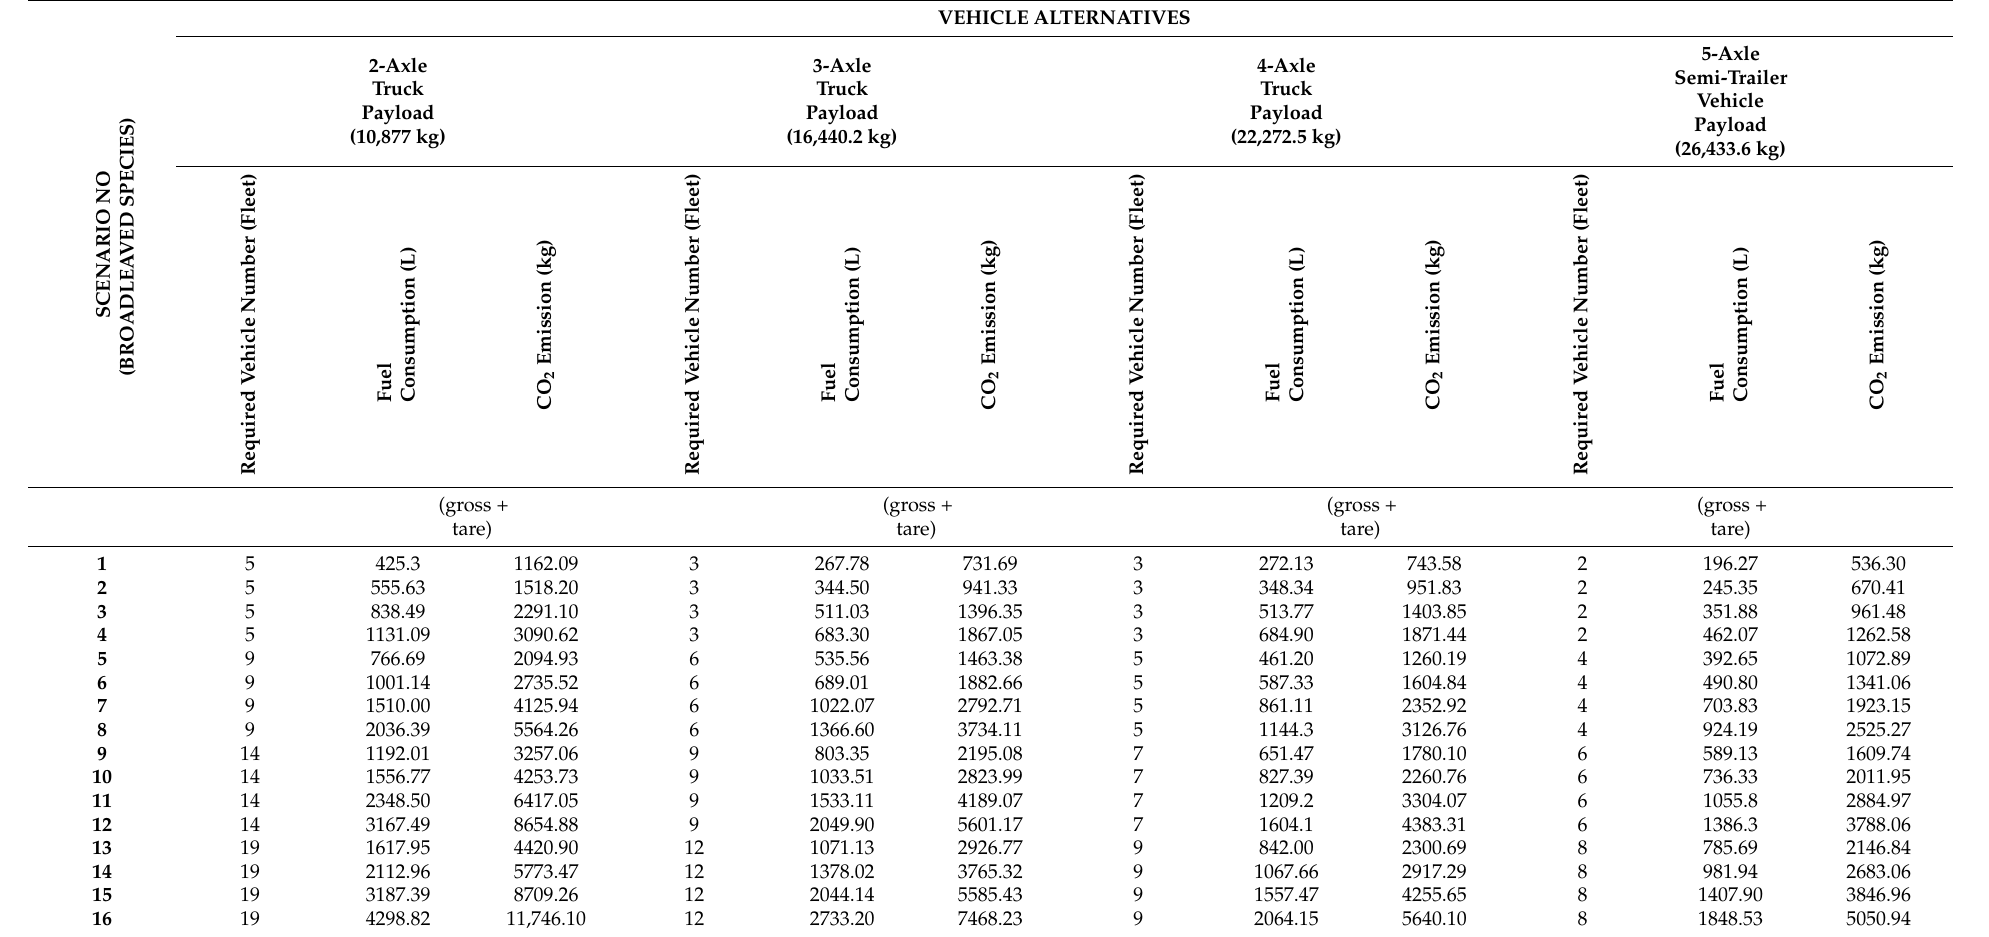
Table 18. Fuel consumption and CO 2 emission values in terms of broadleaved species according to transportation